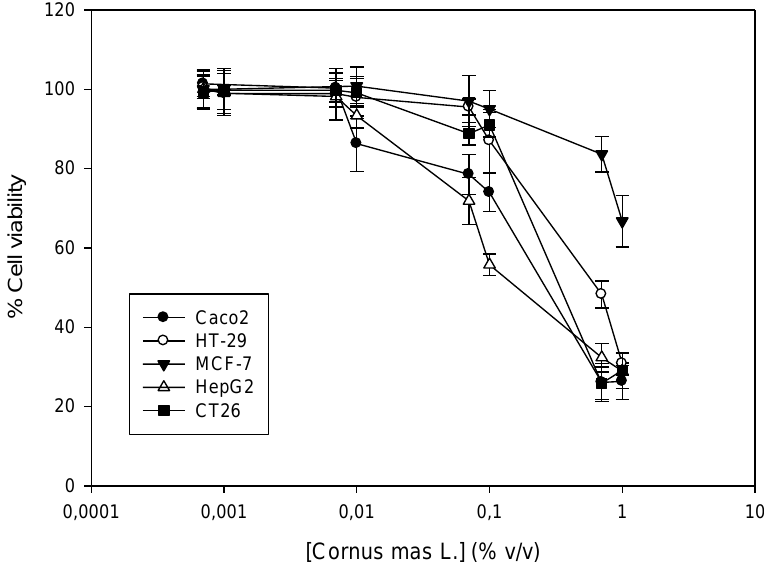
Figure 2. Antiproliferative activity of Cornus mas L. juice against a panel of four human cancer cell lines and one from mice. Human Caco2, HT-29, MCF-7 and HepG2 and murine CT26 cells were incubated with increasing concentrations of the juice (0.0007–1% v/v ) for 72 h. A dose-dependent estimation of cell viability was determined by the Sulforhodamine B (SRB) assay. Representative figure of at least three independent experiments. Table 6. Half maximal Effective Concentration EC 50 (% v/v ) values for Cornelian cherry juice against the human cancer cell lines Caco2, HT-29, MCF-7 and HepG2 as determined by the SRB assay. Cell Lines EC 50 (% v/v ) Caco2